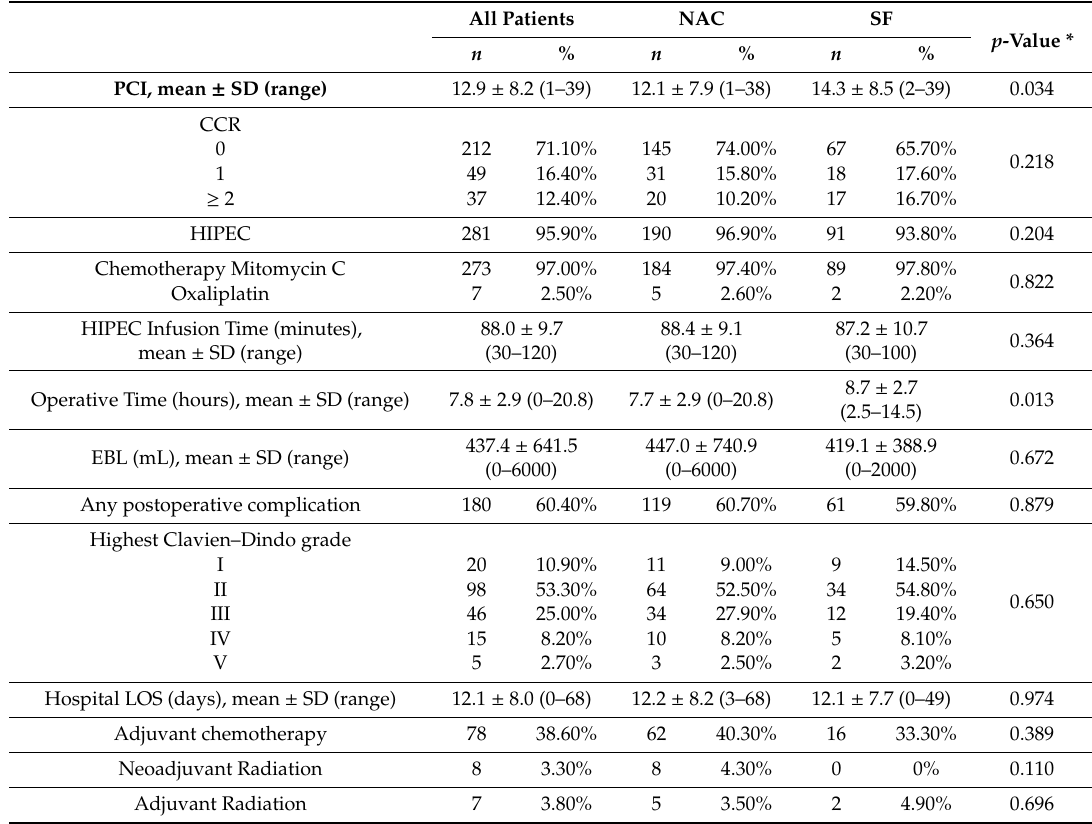
Table 3. Tumor and Operative